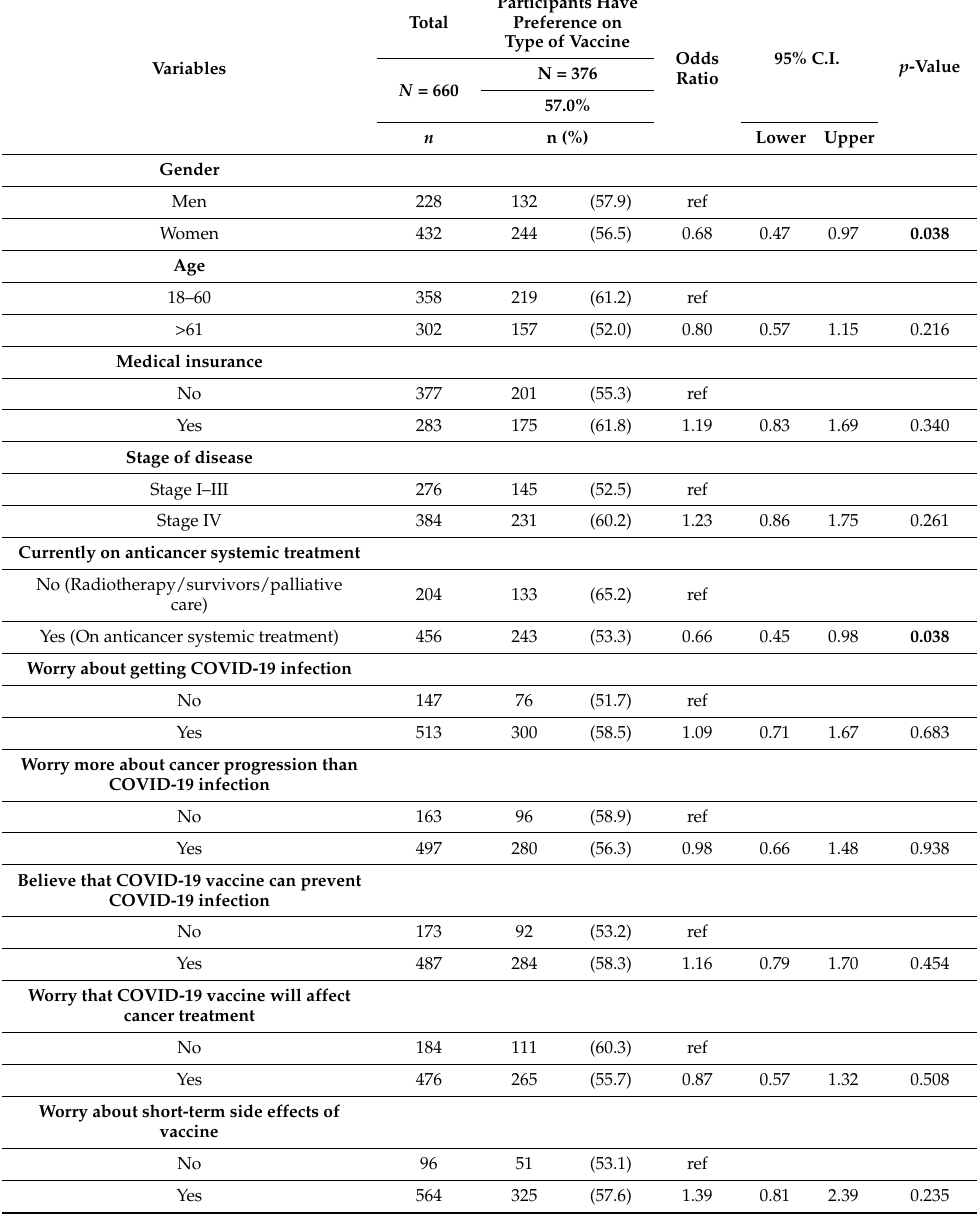
Table 3. Multivariable analysis on factors associated with preference on type of vaccine (preference versus no